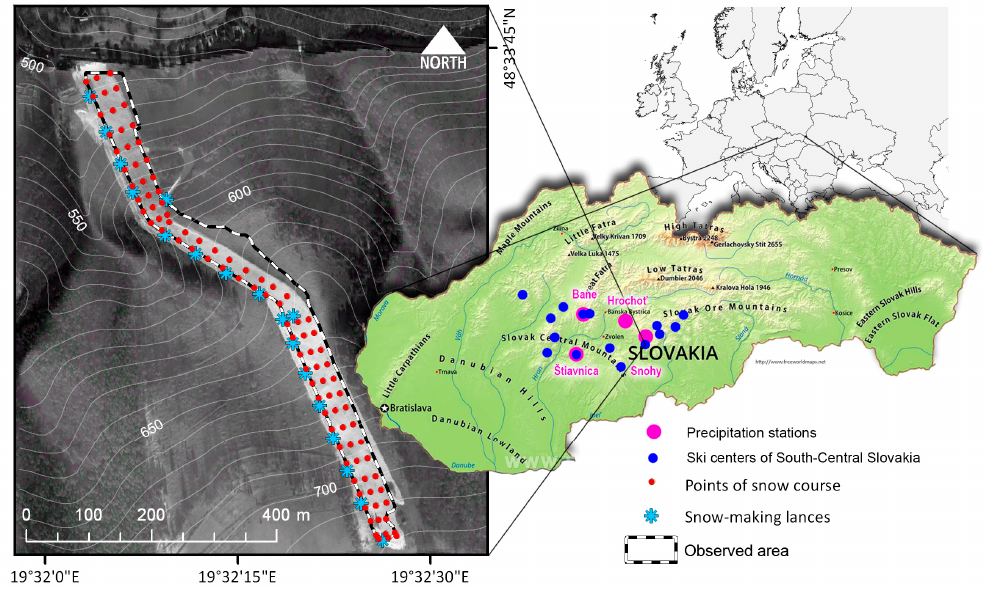
Figure 2. Remaining snowpack on the investigated ski slope of the Košútka Ski Centre (22 March 2011). At the 96 points of the snow course (red dots), the snow depth and density of the snow were measured, while the occurrence of snow was regularly recorded on the “observed area”. The Košútka Ski Centre is situated in South-Central Slovakia (Central Europe), where 15 ski centers (blue dots) and four investigated precipitation stations (pink dots) are located. Other ski centers are out of service because of a lack of natural snow or because of economic problems.